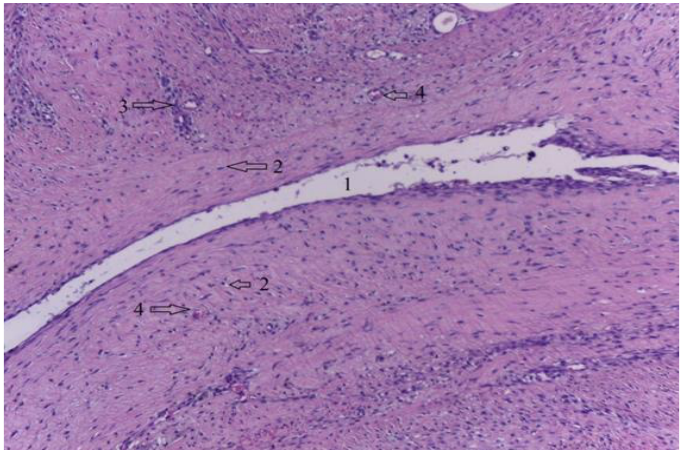
Figure 27. Liver tissue, H-E stain, 10 × 10. 1-Normal liver cells, 2-Normal aspect of bile ducts.